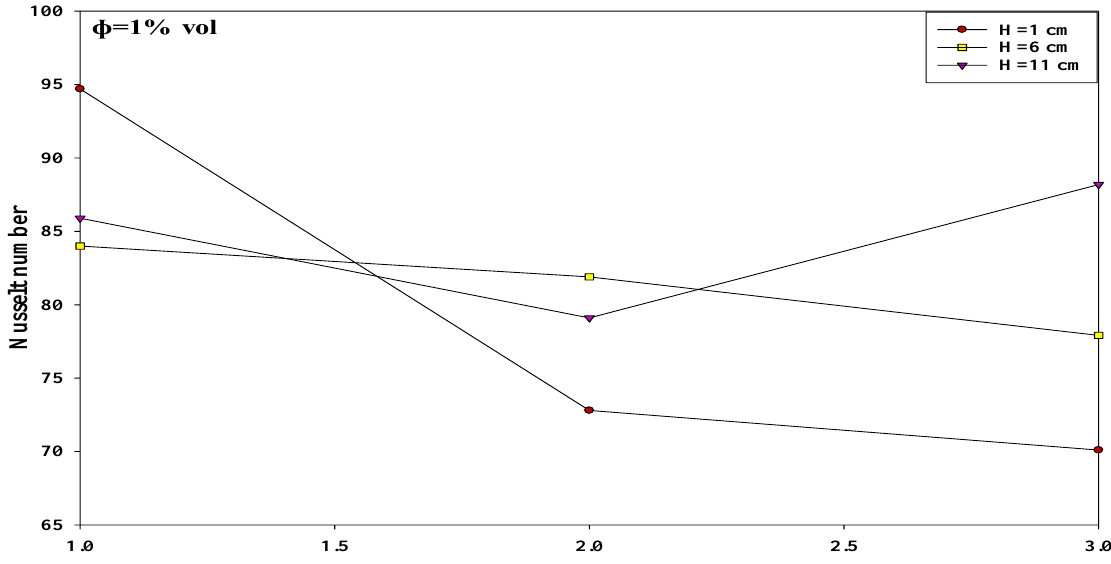
Figure 13. Effect of nozzle–nozzle spacing ( S ) and the nozzle–plate distance ( H ) when other factors were maintained at their optimal levels.